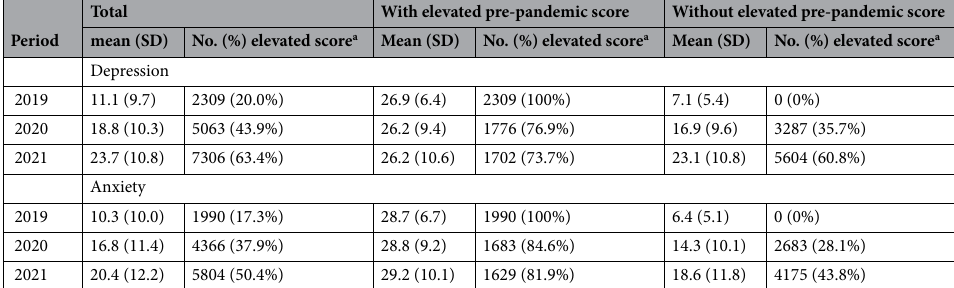
Table 2. Parameters of the PHQ-4 depression and anxiety subscales for different periods before and during the COVID-19 pandemic (N = 11,523) in both groups (with vs. without pre-pandemic depression/anxiety). All bivariate comparisons between both groups are significant at level p < .001. a Scores equal to 20 or above were categorized as elevated scores in depression/anxiety. The cut-off at 20 is based on an established cut-off score applied to the modified response scale.